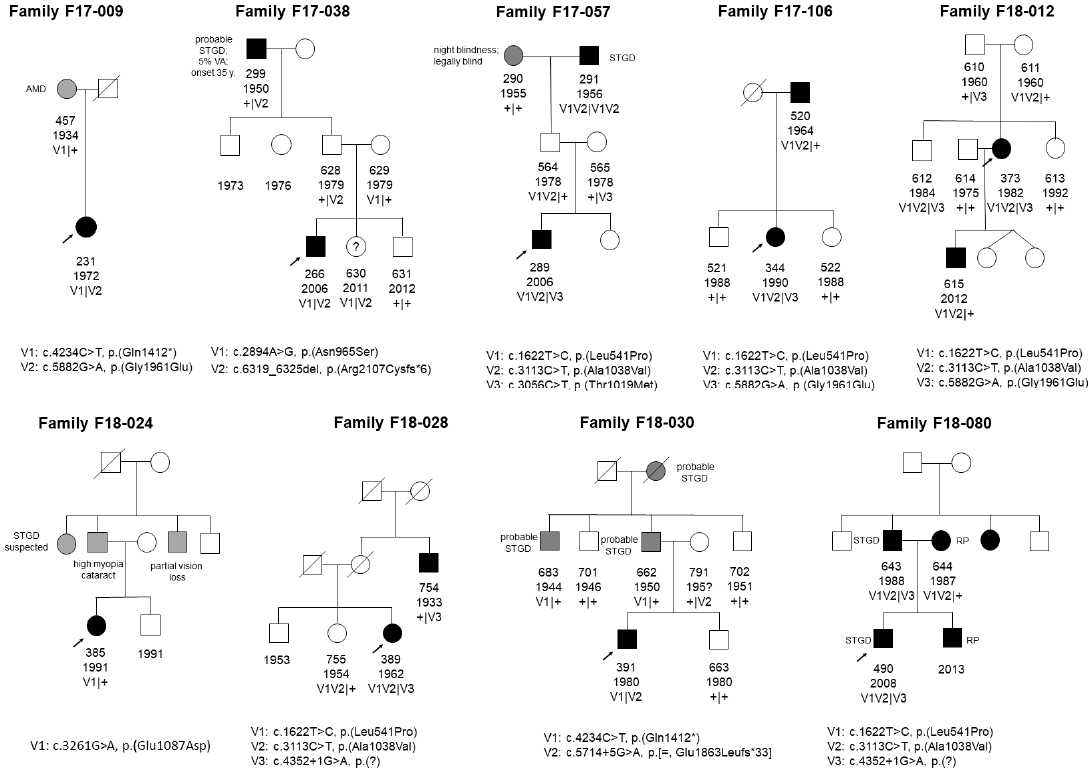
Figure 1. Pedigrees of nine families with pseudo-dominant inheritance pattern. Various phenotypes are present within families. Only variants detected in probands were sequenced in family members. Patient 385 remains unsolved. AMD = age-related macular dystrophy; STGD = Stargardt disease; RP = retinitis pigmentosa; VA = visual acuity; V = variant.